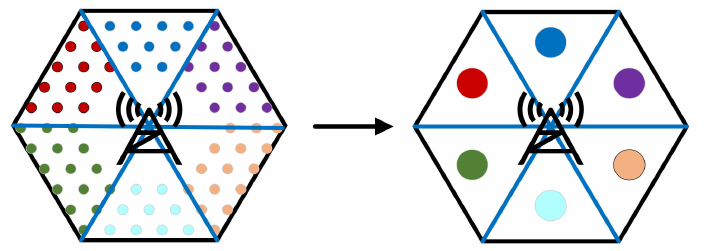
Figure 4. Schematic of the user clustering